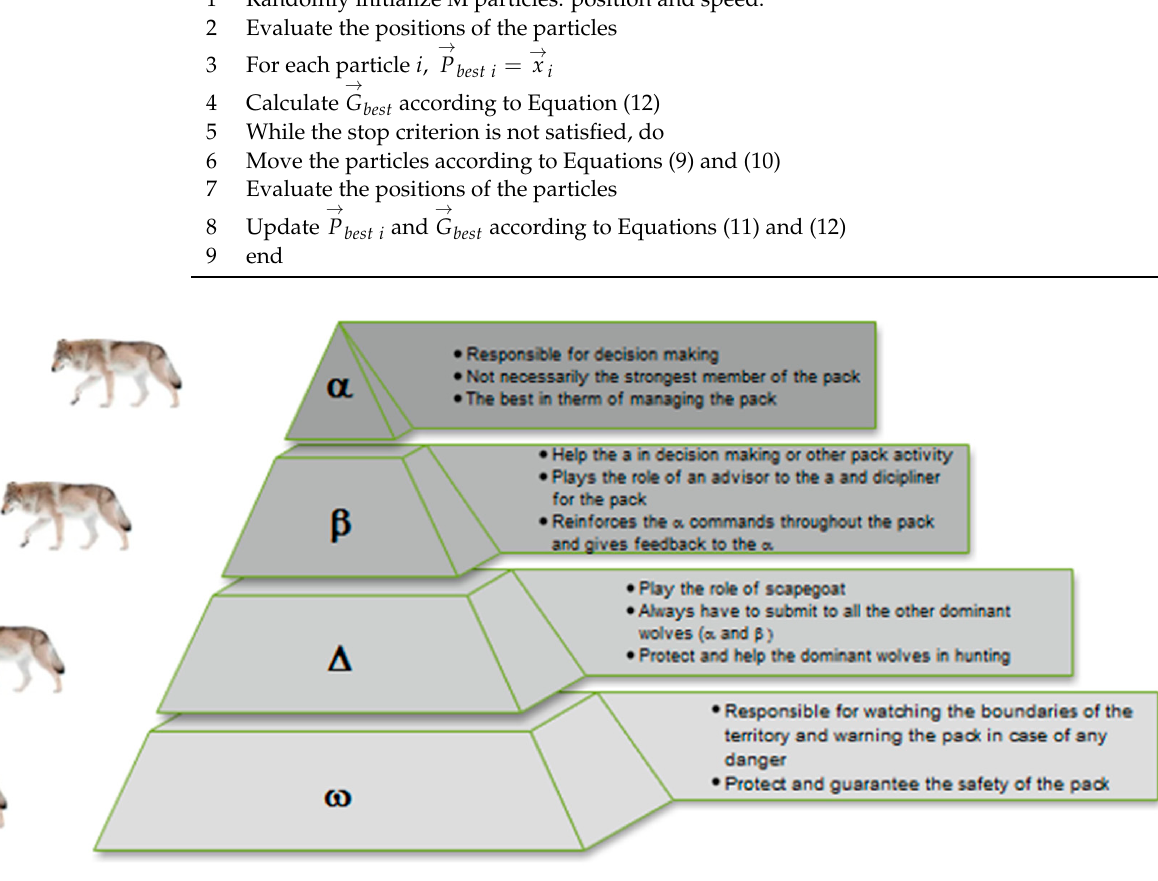
Figure 6. Hierarchical levels of grey wolves and their tasks .